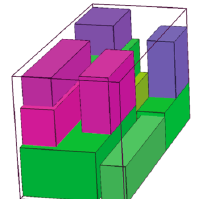
Fig. 6. Example of a packing solution using the GRASP algorithm